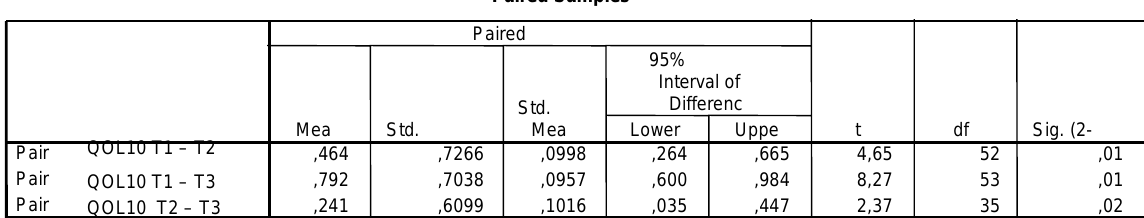
with Clinical Holistic